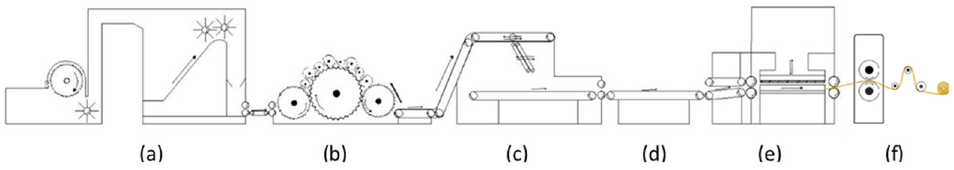
Figure 1. Manufacturing process diagram for nonwoven fabrics that involves with ( a ) the hopper feeder; ( b ) carding machine; ( c ) Folding machine; ( d ) transmission band; ( e ) needle punching machine; ( f ) Drum heat press. Table 1. Manufacturing parameters of nonwoven fabrics.